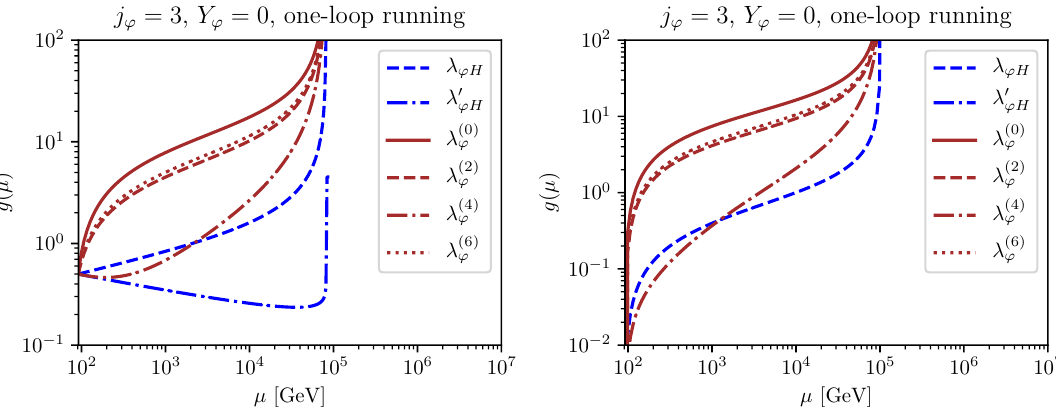
Figure 5. One-loop running of scalar quartic couplings for j ’ = 3 with Y ’ = 0 (\Minimal Scalar Dark Matter"). The dashed and dash-dotted lines denote the Higgs-portal couplings (cid:21) ’H and (cid:21) 0 , respectively, while the solid lines denote the four scalar couplings (cid:21) ( J ) ’ , for J = 0 ; 2 ; 4 ; 6. The ’H running at one-loop exhibits a Landau pole around (cid:22) = 10 5 GeV. Left panel: all initial conditions are set to 0.5 at (cid:22) = M Z . Right panel: vanishing initial conditions at (cid:22) = M Z . m (pole) = 172 : 4(7) GeV t